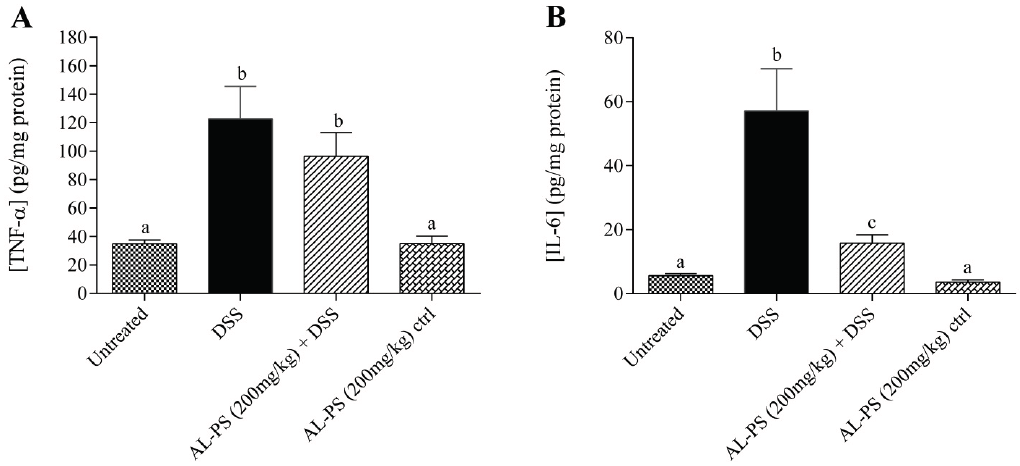
Figure 3. Effect of AL-PS on the concentration of ( A ) TNF- α and ( B ) IL-6 in DSS-induced colitis. Data represent means ± SEM of n = 6 mice/group. Different letters indicate statistically significant differences at p <